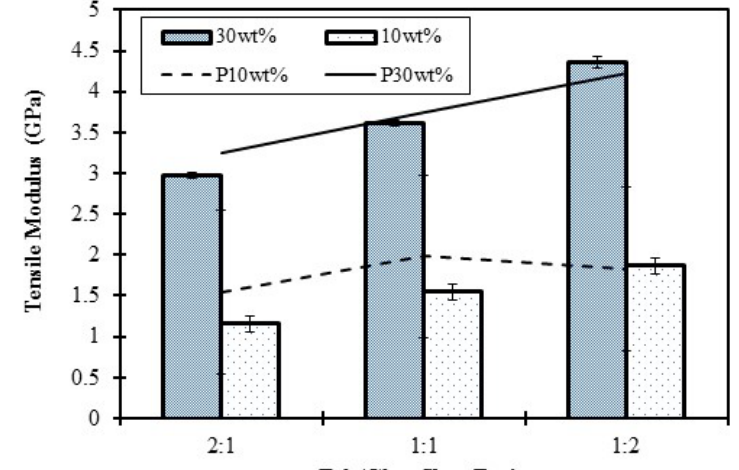
Figure 6. Tensile modulus of composites filled with combined glass fiber and talc fillers. Lines in the upper chart showing predicted